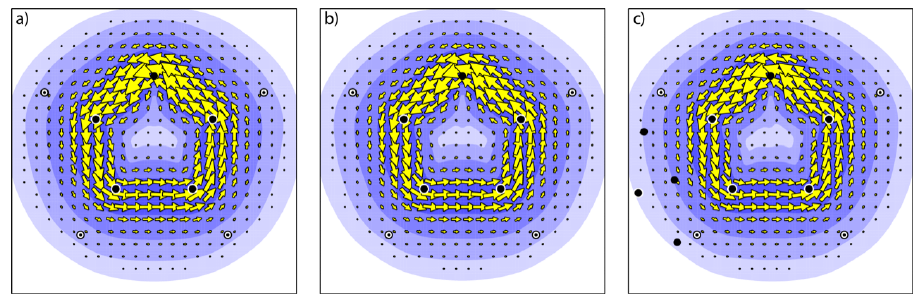
Figure 4. Plots of the π -current density for ( a ) furan, ( b ) CF 3 I · · · furan ( (cid:107) ), and ( c ) CF 3 I · · · furan ( ⊥